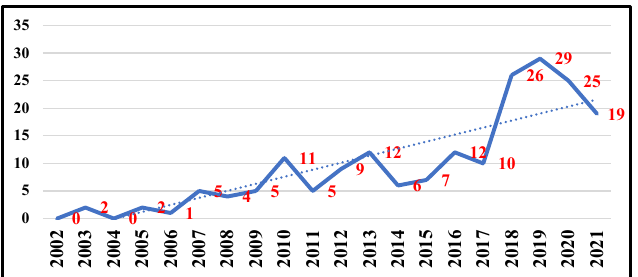
Figure 2. Publication by Year (Trendline = dotted line; Data series pattern = solid blue line).